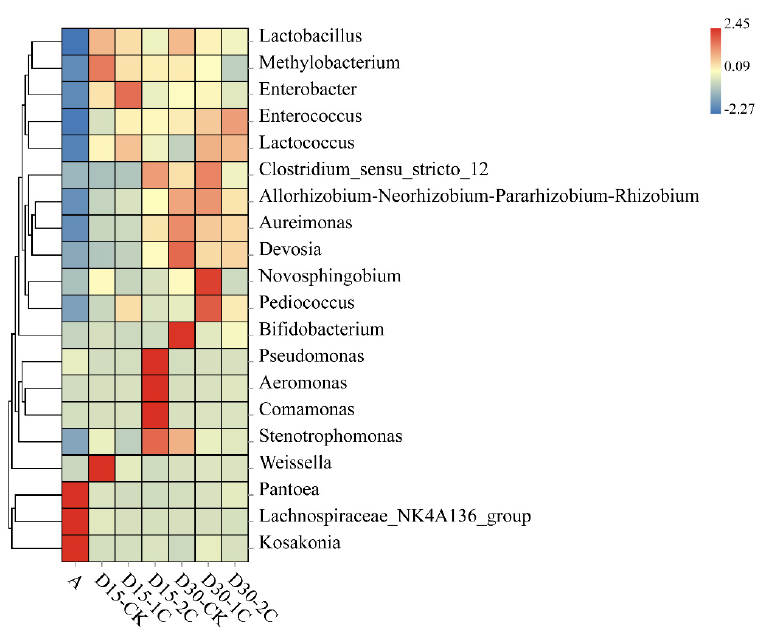
Figure 3. Heatmap of prominent microbial genera (20 most abundant genera) for alfalfa silage (A, fresh alfalfa; CK, the control; 1C, 1% biochar; 2C, 2% biochar; D15, D30, after 15, 30 days ensiling, respectively).